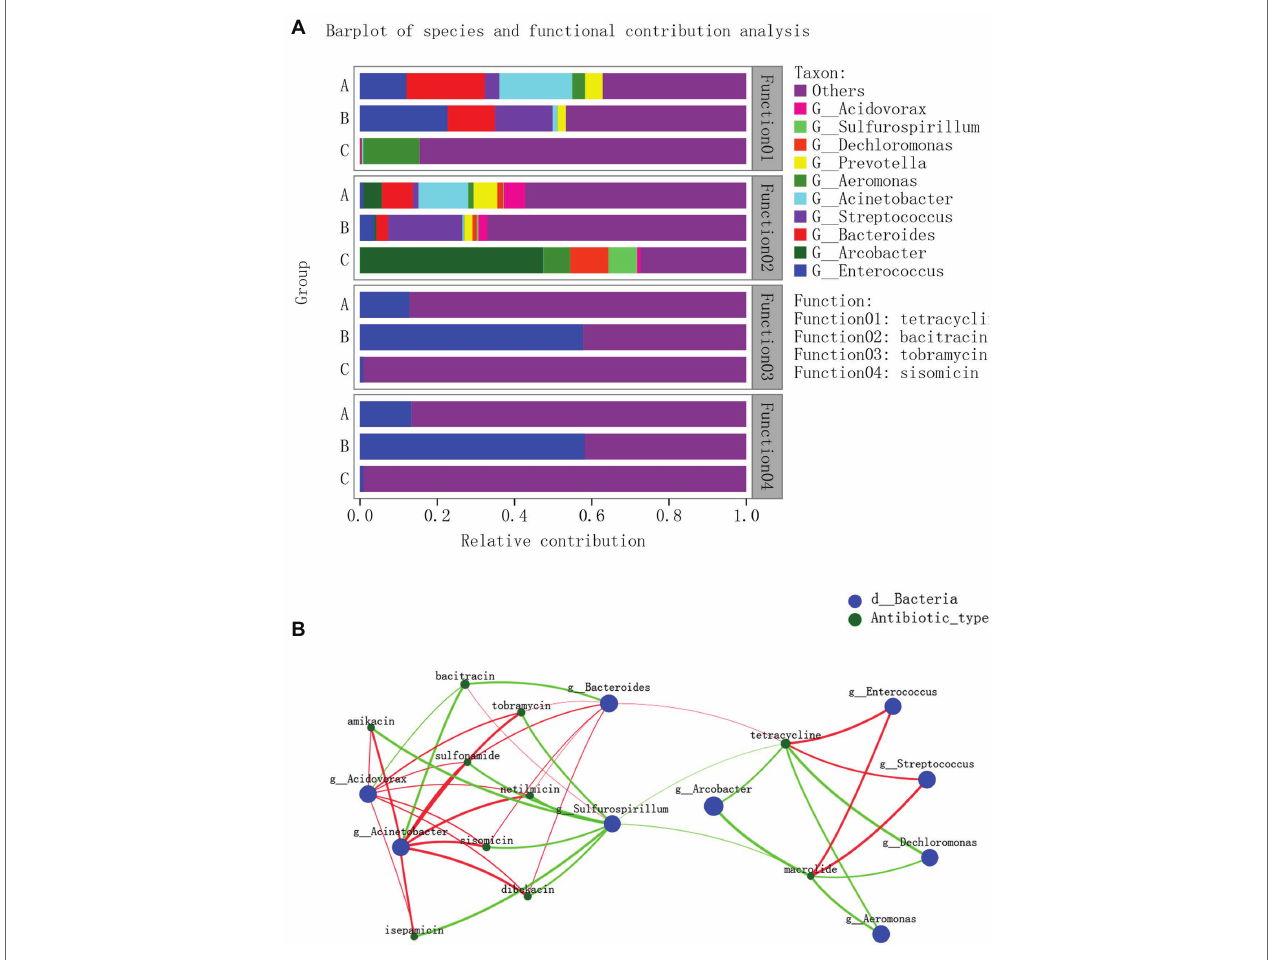
FIGURE 5 | Correlations between species and corresponding ARGs. (A) Correlation of microbiota genus and ARGs relative antibiotics type; (B) Correlation of microbiota genus and comprehensive ARGs on antibiotic type level. The nodes were colored according to ARG types and genus. A connection represents a strong Spearman’s correlation coefficient ( ρ > 0.5) and significant (value of p < 0.05) correlation. The color of the line indicates positive and negative correlation, red indicates positive correlation, and green indicates negative